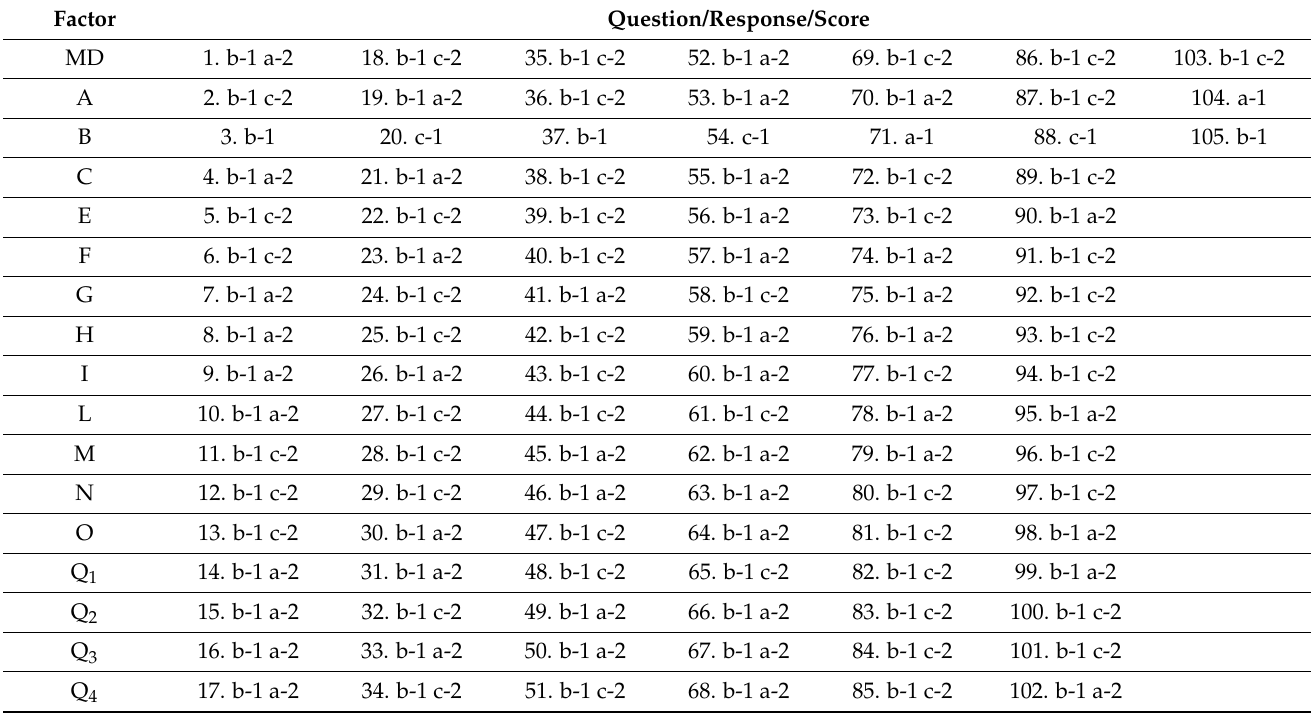
Table 3. Table 2. Scoring chart for the 16PF questionnaire.